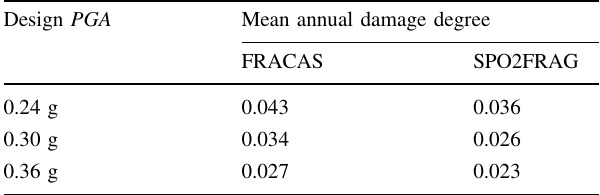
Table 4 Comparison of the mean annual damage degrees for struc- tures in Bucharest, Romania, using the FRACAS and SPO2FRAG methodologies as a function of the level of design peak ground acceleration ( PGA )